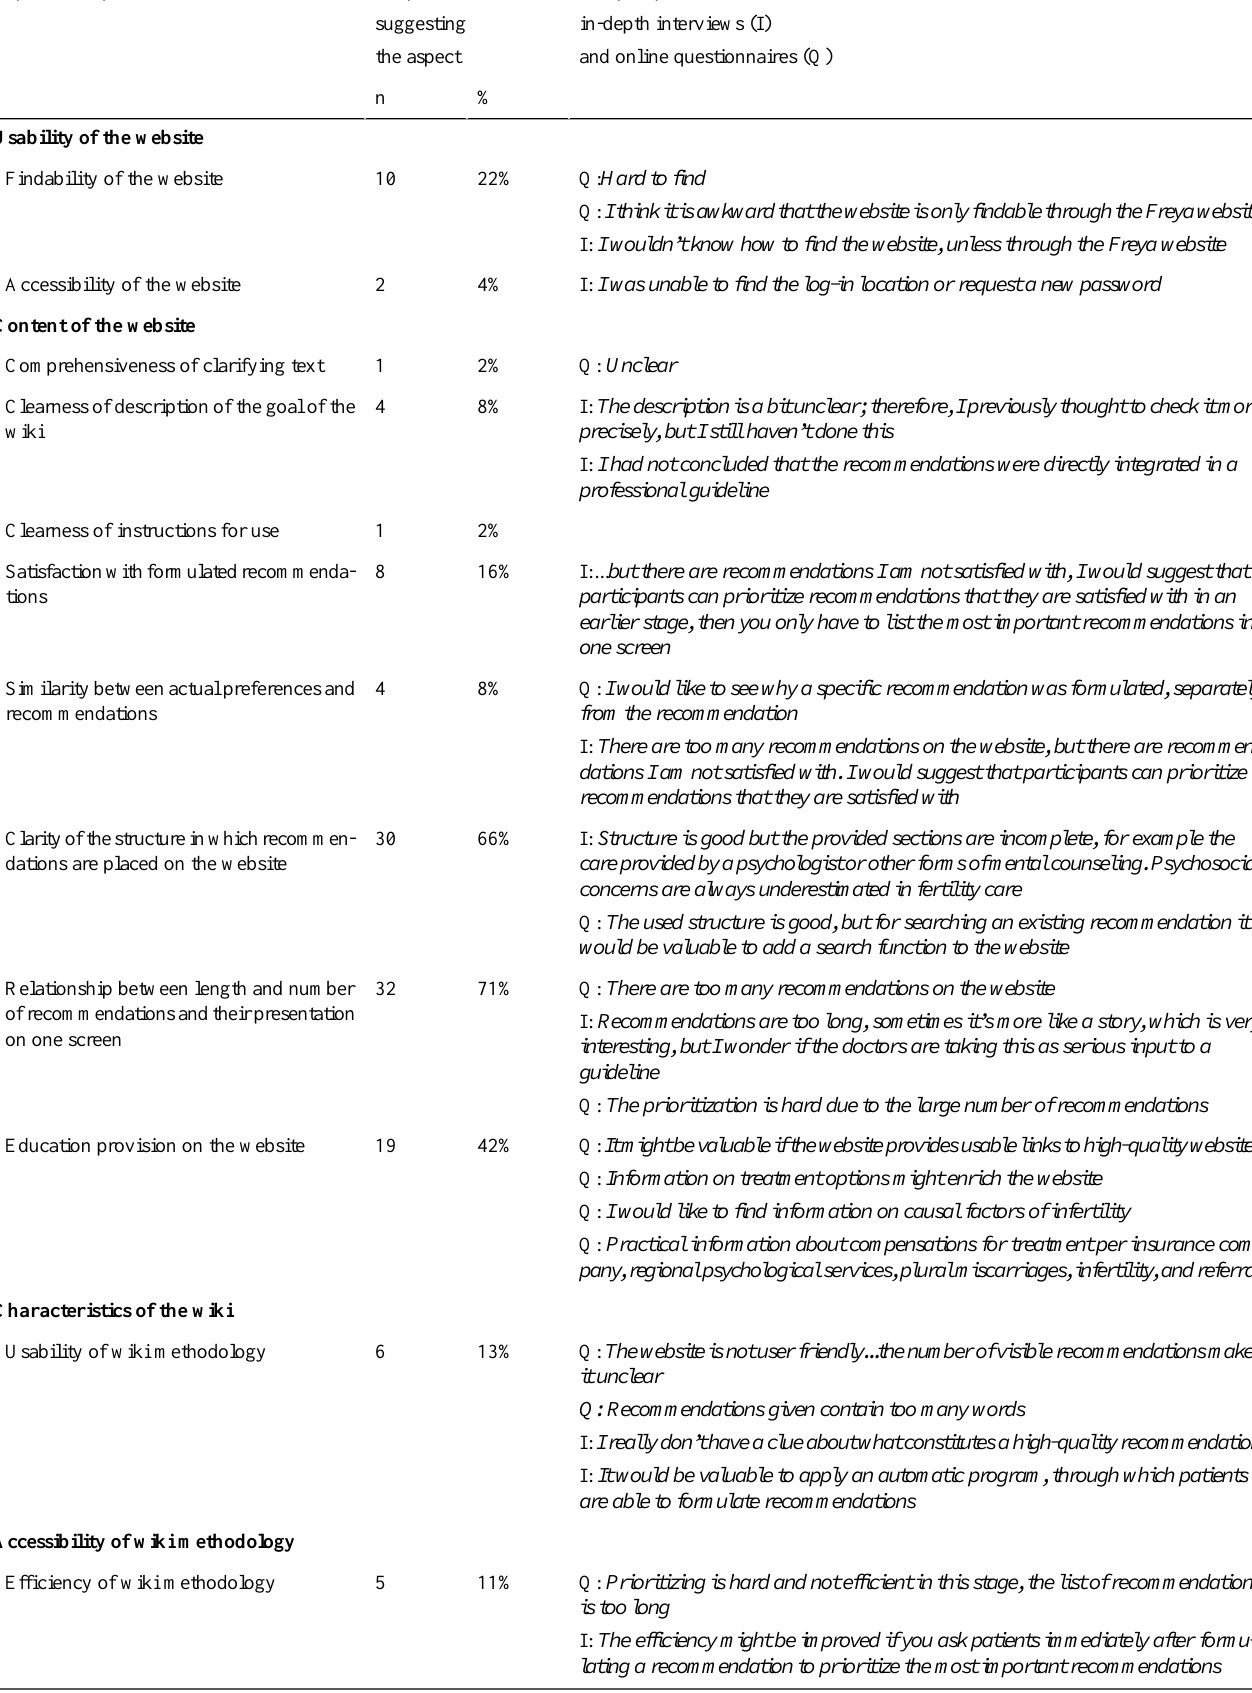
Table 4. Participants’(n = 45 a ) suggestions for improving the wiki website.